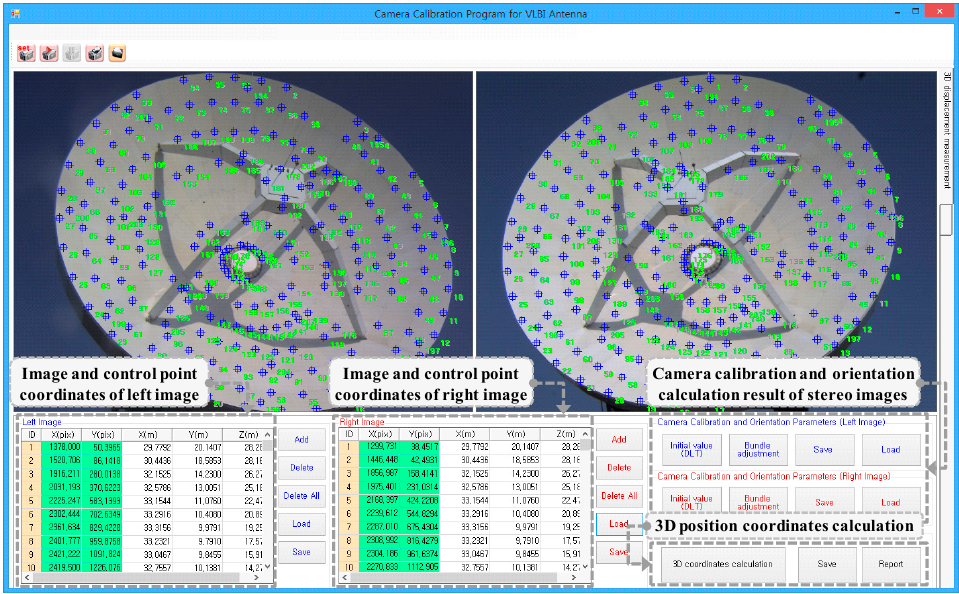
Figure 10. Operation screen of the VLBI antenna static displacement monitoring program.